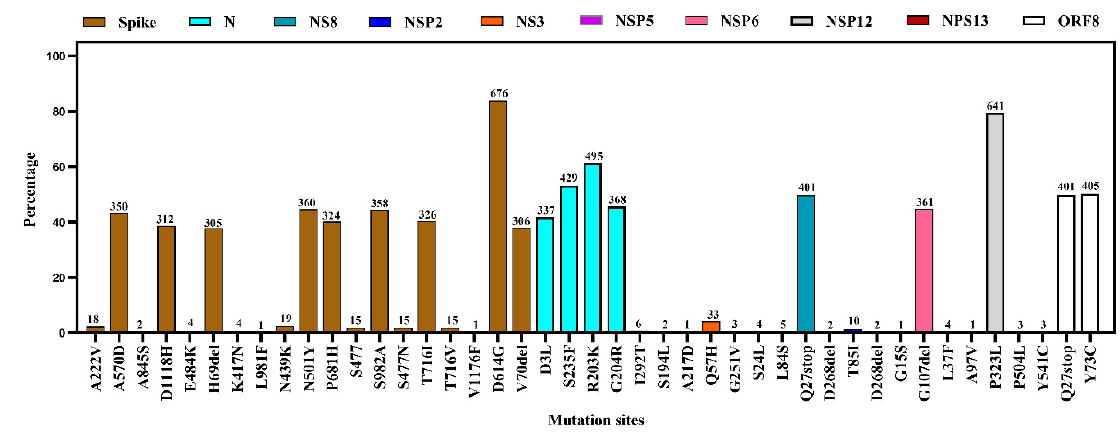
Figure 8. Proportion of amino acid mutations in different segments of SARS-CoV-2 environmental strains.